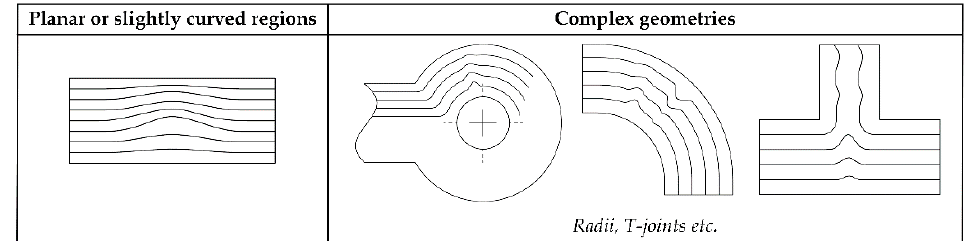
Figure 37. Waves in flat or slightly curved areas vs. complex geometries.